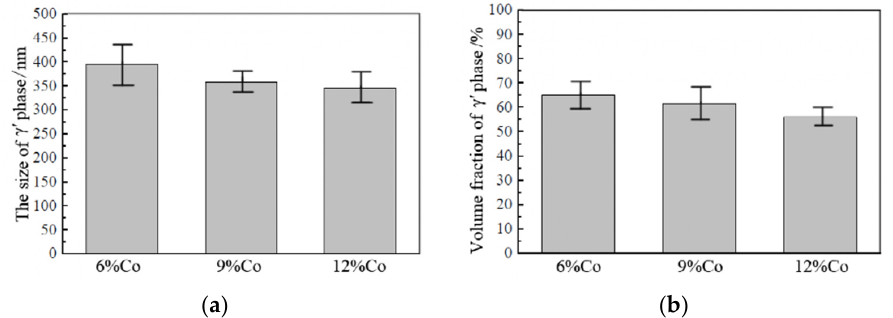
Figure 4. The effect of Co content on the size and volume fraction of γ′ phase: ( a ) size of γ′ phase and ( b ) volume fraction of γ′ phase.